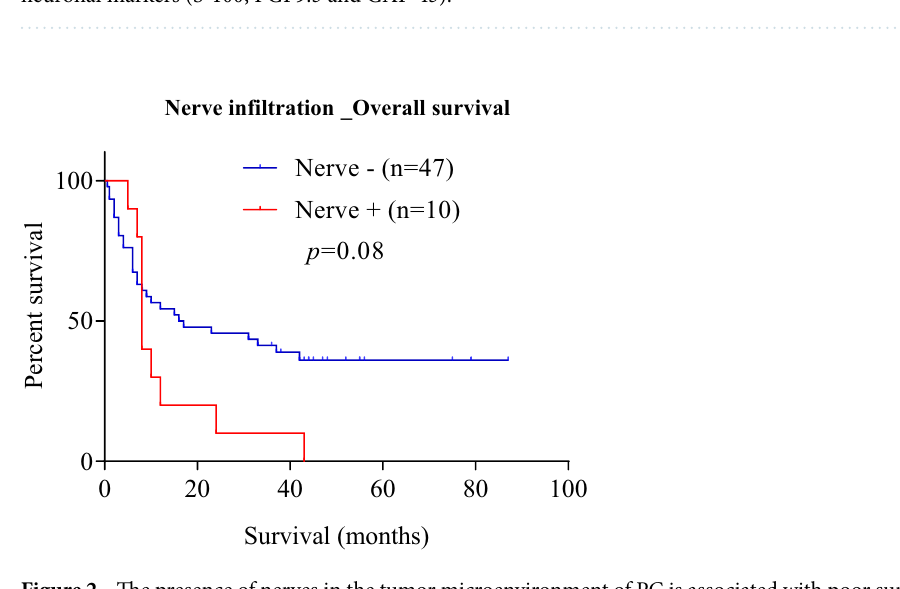
did not reach statistical significance ( p = 0.07, Fig. 3I). For patients with higher (T3) tumor size, nerve infiltration